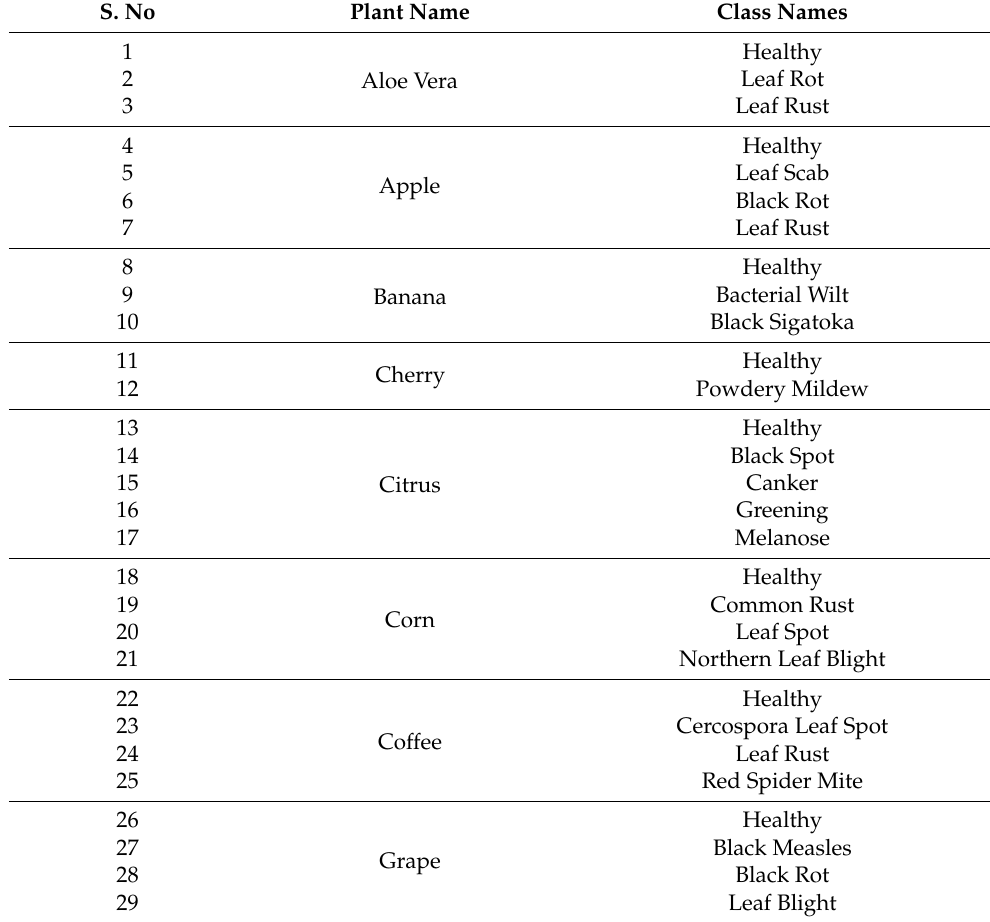
Table 2. List of classes in the proposed